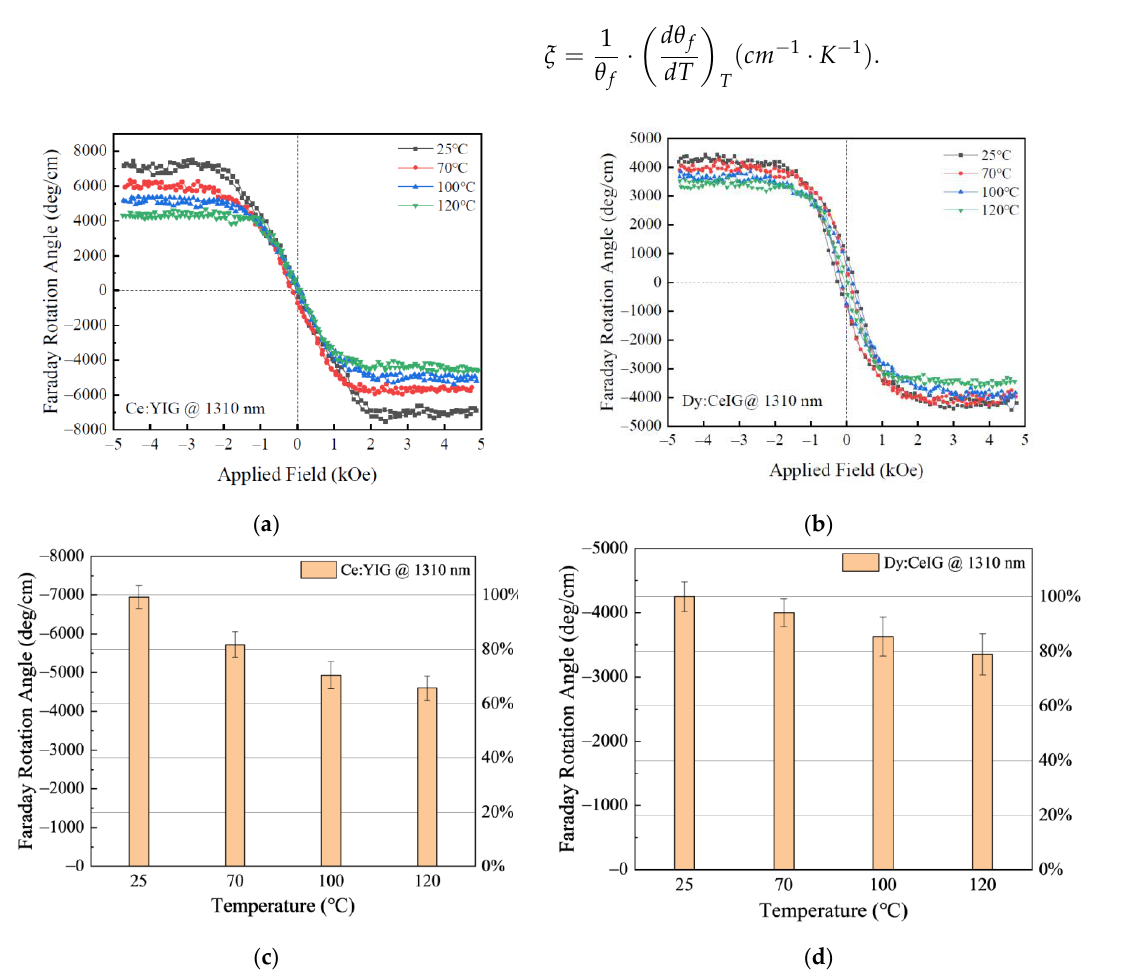
Figure 2. Temperature dependence of the Faraday rotation (FR) hysteresis loops at 1310 nm wave- length of ( a ) Ce:YIG and ( b ) Dy:CeIG thin films on silicon. Curves of different colors indicate different temperatures. Faraday rotation angle of both films as functions of temperature: ( c ) Ce:YIG and ( d ) Dy:CeIG. The error bar is the standard deviation from three consecutive measurements at the same